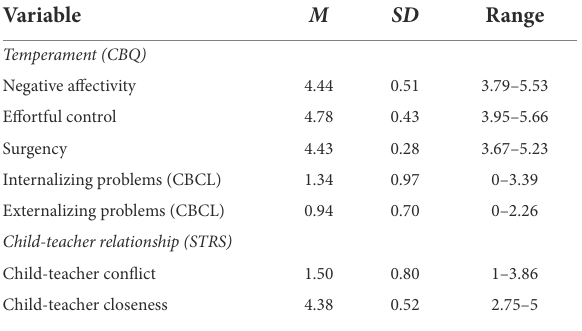
TABLE 1 Descriptive statistics for study variables.